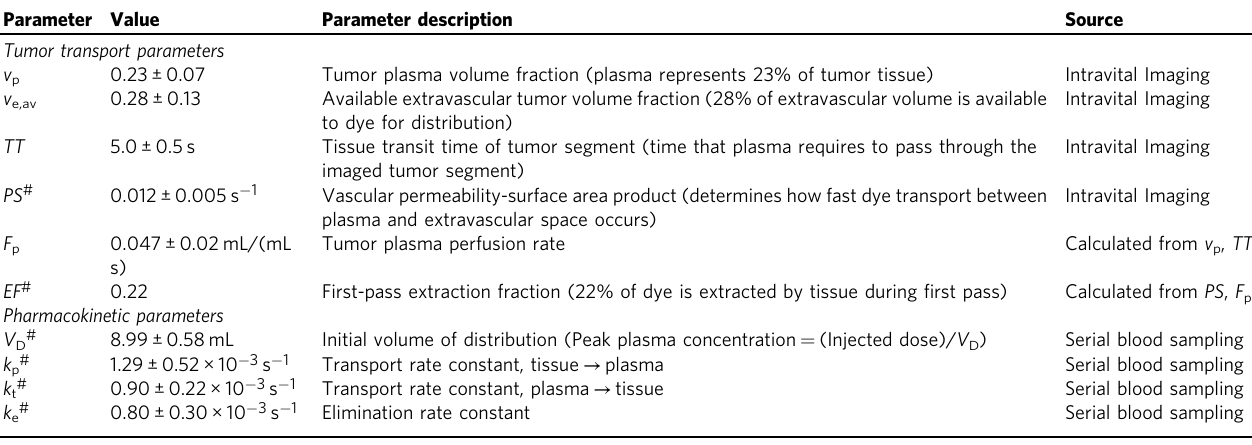
The table is separated into two sections identi fi ed by the labels “ Tumor transport parameters ” and “ Pharmacokinetic parameters ” . Column headings are identi fi ed in bold font. # Parameters are speci fi c to the employed drug/dye, here carboxy fl uorescein (CF).